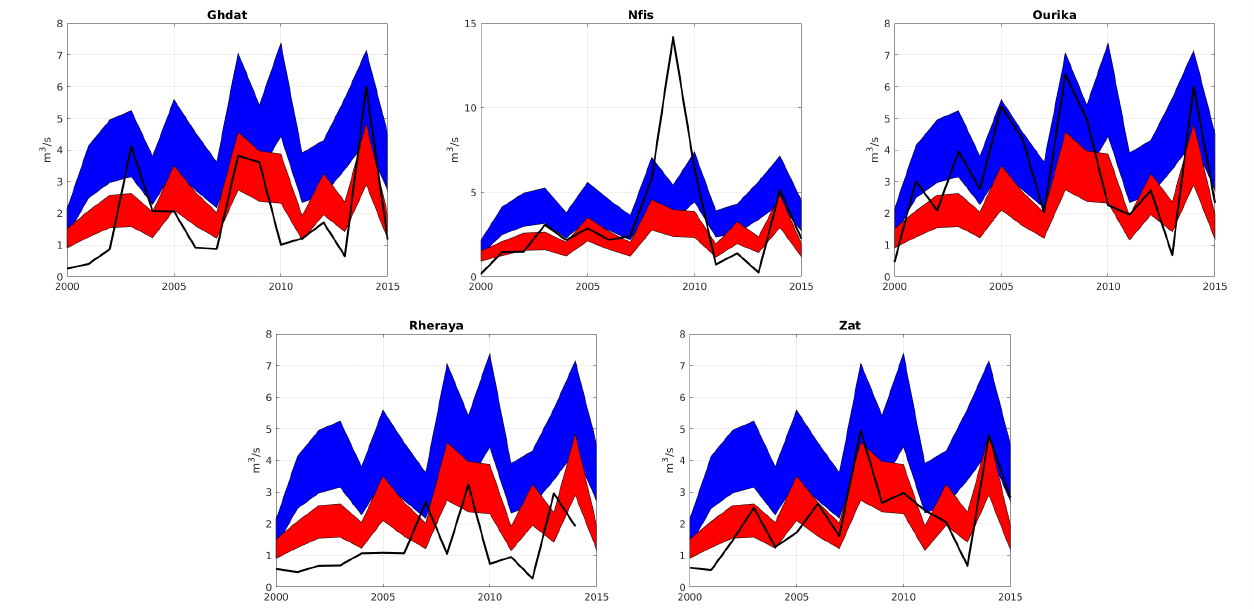
Figure 5. Comparison between observed mean annual discharge (black) and modeled mean daily surface water input (m 3 /s). The blue windows represent ERA5 modeled surface water input (30% to 50%), and the red ones represent MERRA-2 modeled surface water input (30% to 50%).